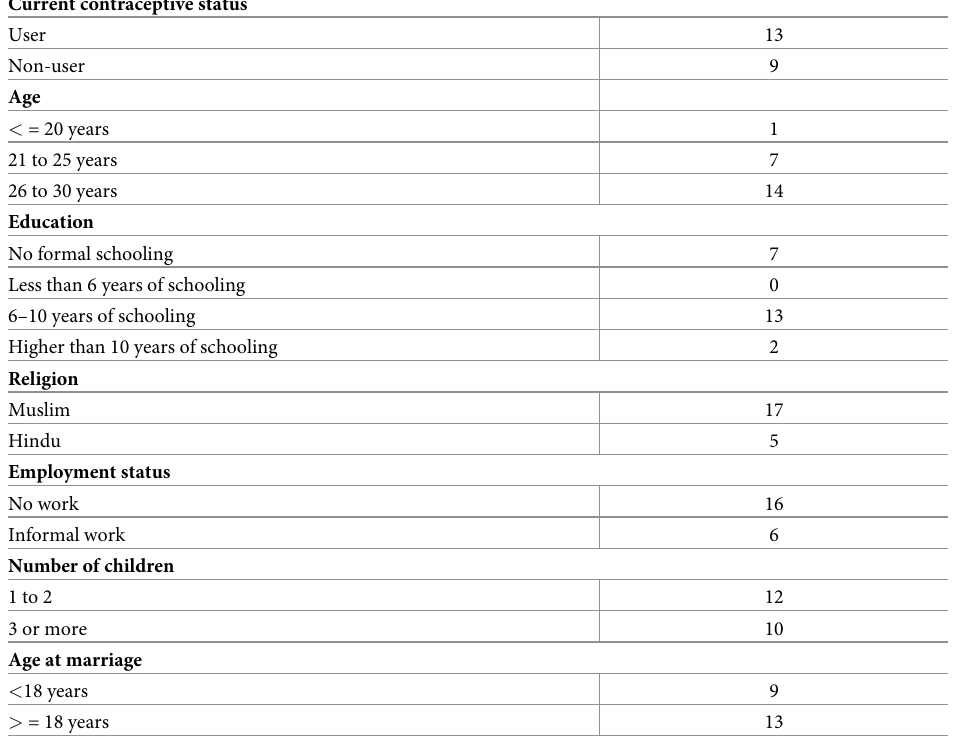
Table 1. Demographic characteristics of the interview participant from the project area in Malvani, Mumbai (N =